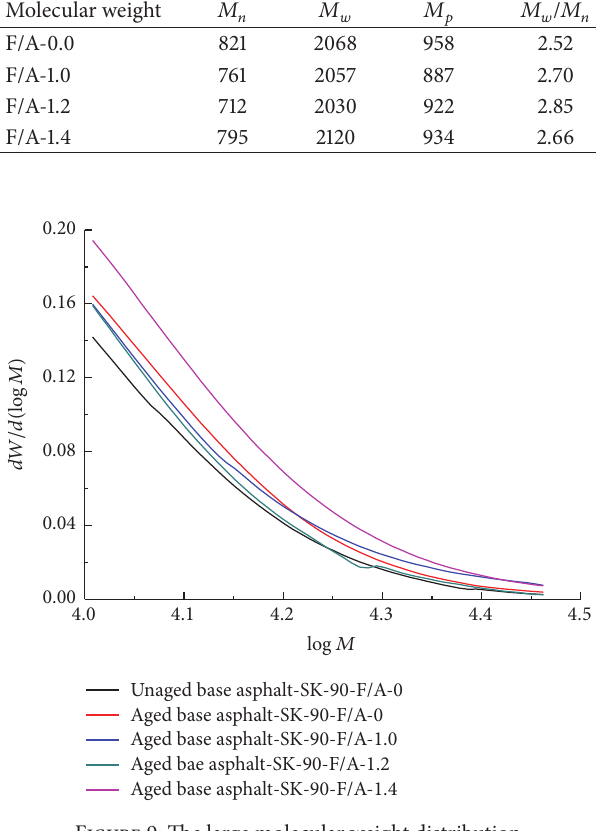
Figure 9: The large molecular weight distribution.